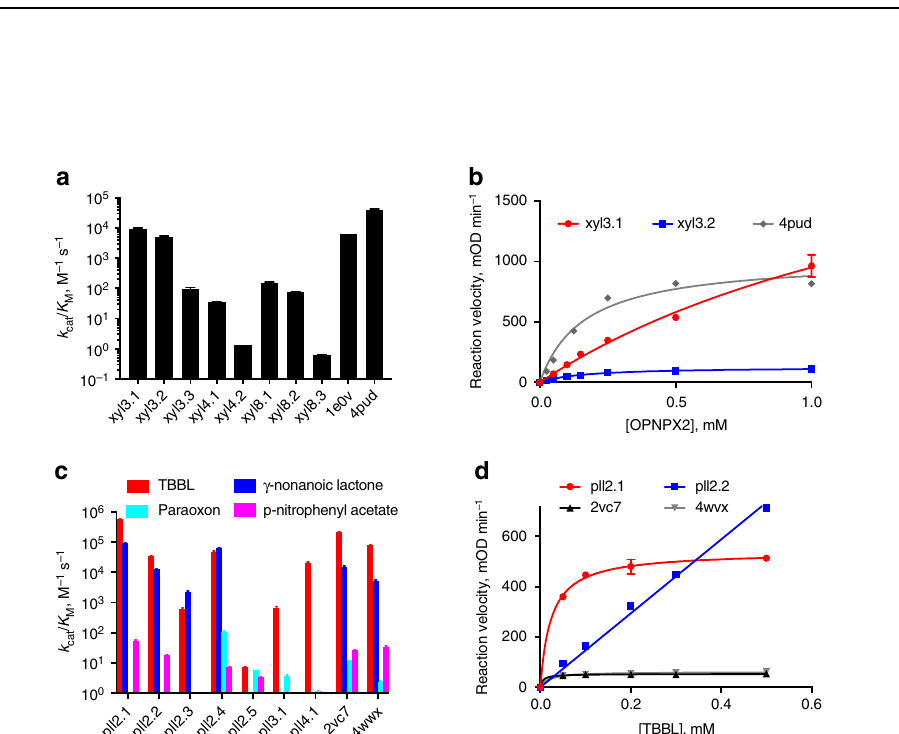
Fig. 3 High catalytic ef fi ciencies in GH10 and PLL designs. a Catalytic ef fi ciency of GH10 designs with OPNPX 2 compared to natural GH10 enzymes (GH10s from S. lividans and G. stearothermophilus , PDB IDs 1E0V and 4PUD, respectively). Reaction velocities were normalized to 1 μ M protein. b Michaelis-Menten curves of the most active GH10 designs relative to a natural GH10 (PDB ID: 4PUD). c Catalytic ef fi ciency of PLL designs with various substrates compared to natural PLLs (from S. solfataricus and G. kaustophilus , PDB IDs 2VC7 and 4WVX, respectively). d Michaelis-Menten curves of the most active PLL designs and natural PLLs with TBBL. Reaction velocities were normalized to 0.1 μ M protein. Data are the means ± standard deviation of duplicate